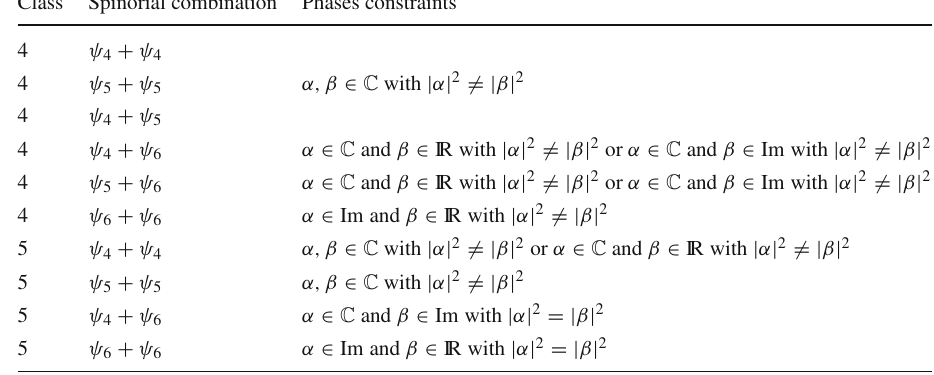
for the Lounesto’s singular